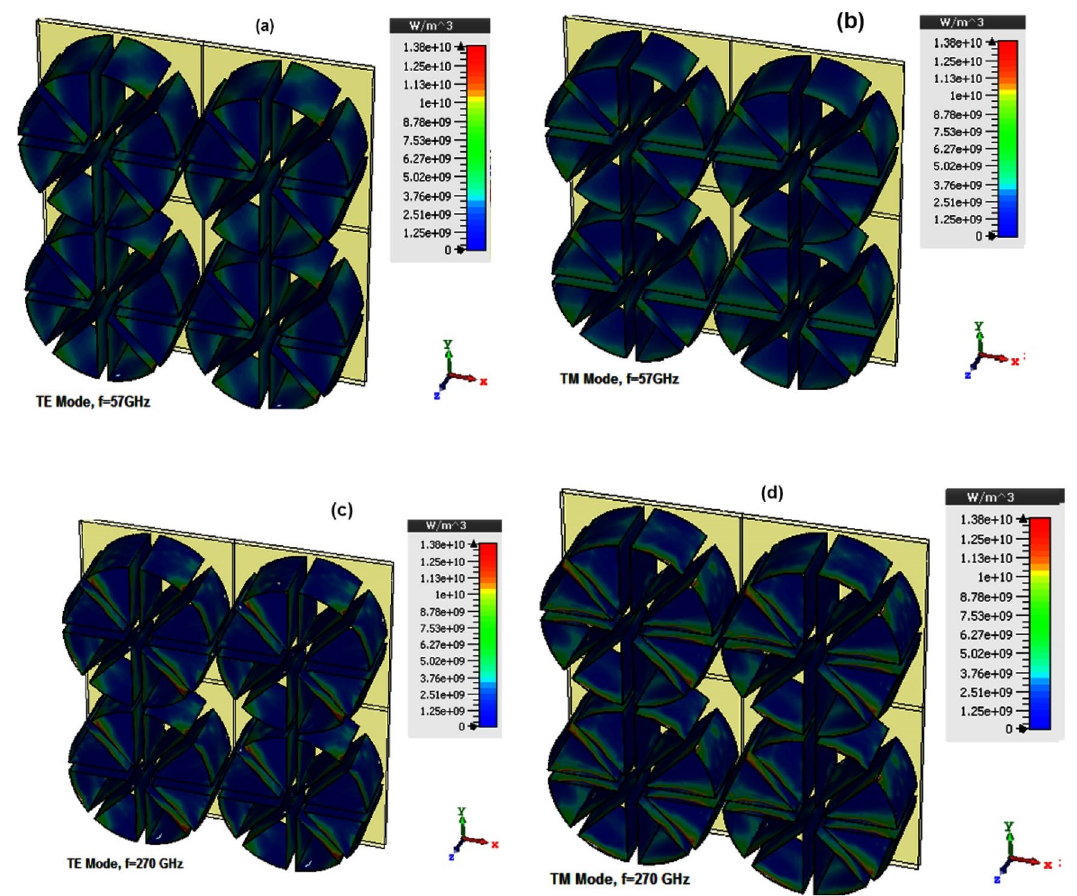
Figure 6. The power loss density at ( a ) f = 57 GHz, TE mode ( b ) f = 57 GHz, TM mode ( c ) f = 270 GHz, TE mode and ( d ) f = 270 GHz, TE mode.